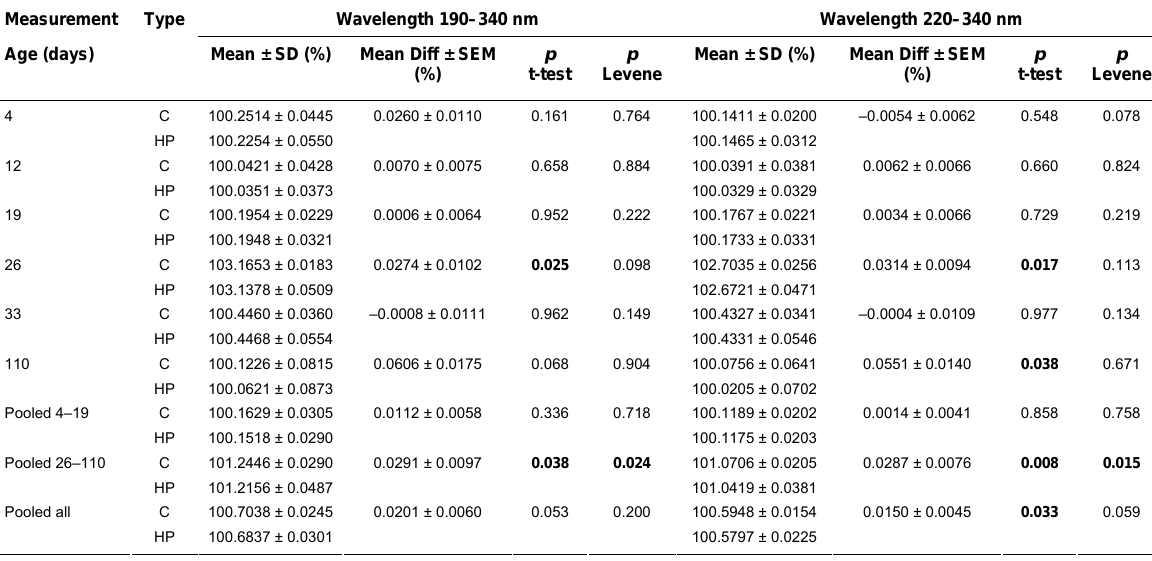
Homeopathic Preparations and Controls without 4